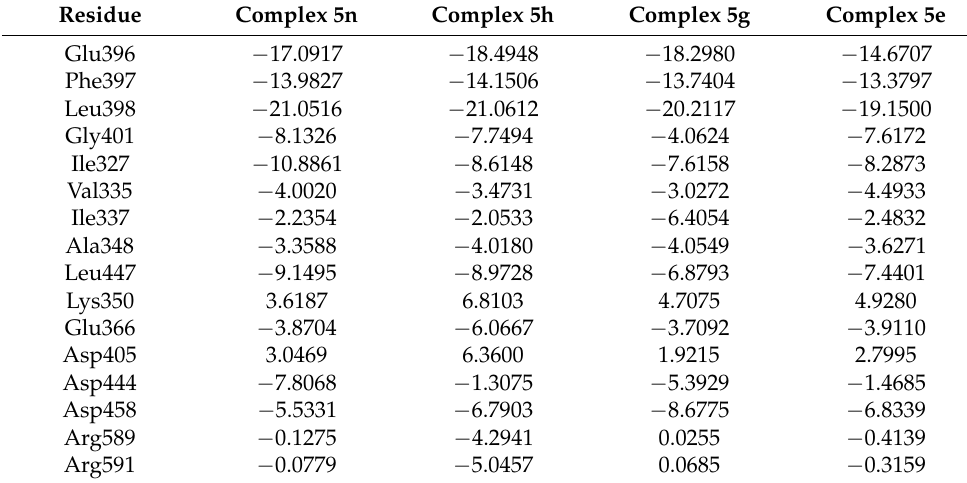
Table 1. The E MM contributions of important residues (kJ · mol − 1 ).